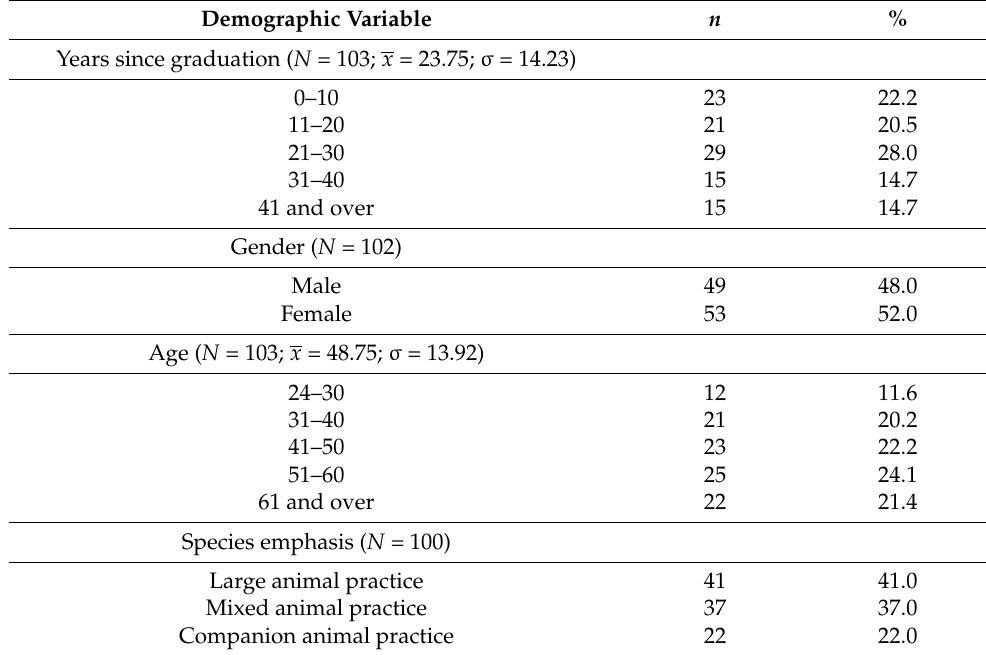
Table 3. An overview of the sample demographics. Demographic Variable n % Years since graduation ( N = 103; x = 23.75; σ =